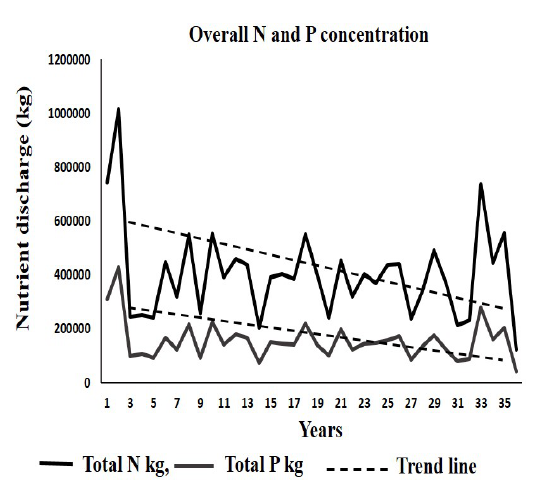
Figure 8. Total concentration of N and P over 35 years